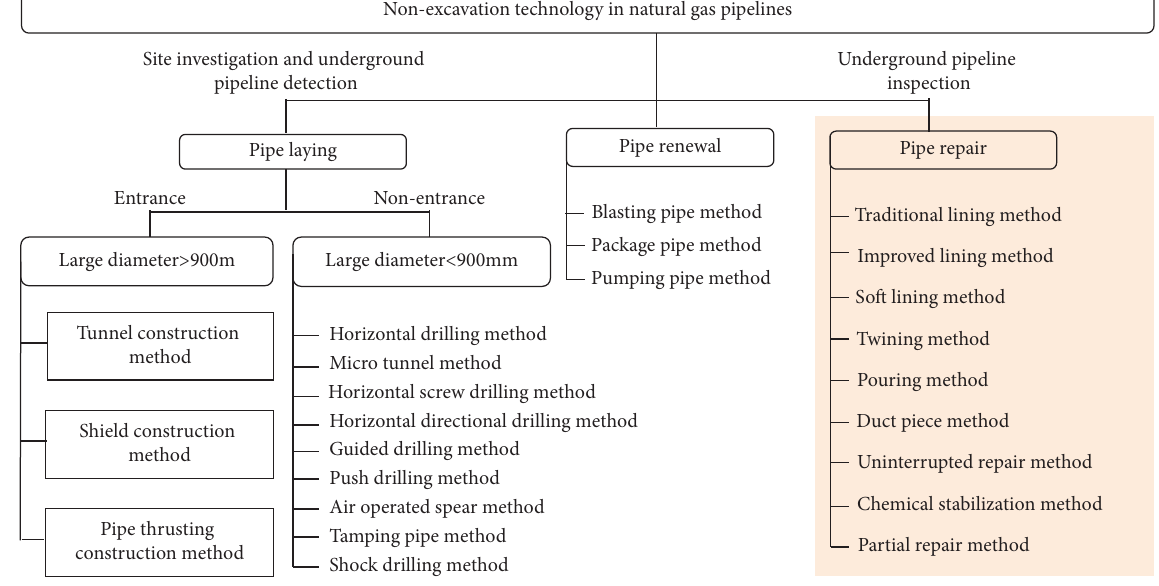
Figure 10: Nonexcavation technology of construction, renewal, and repair for natural gas